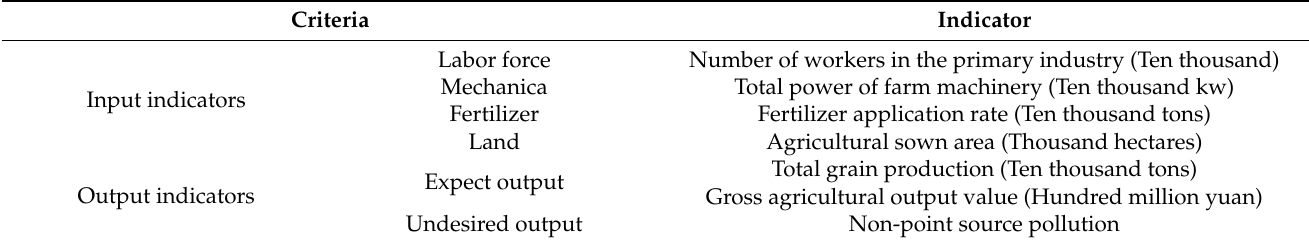
Table 1. Quantitative evaluation index system for cultivated land use